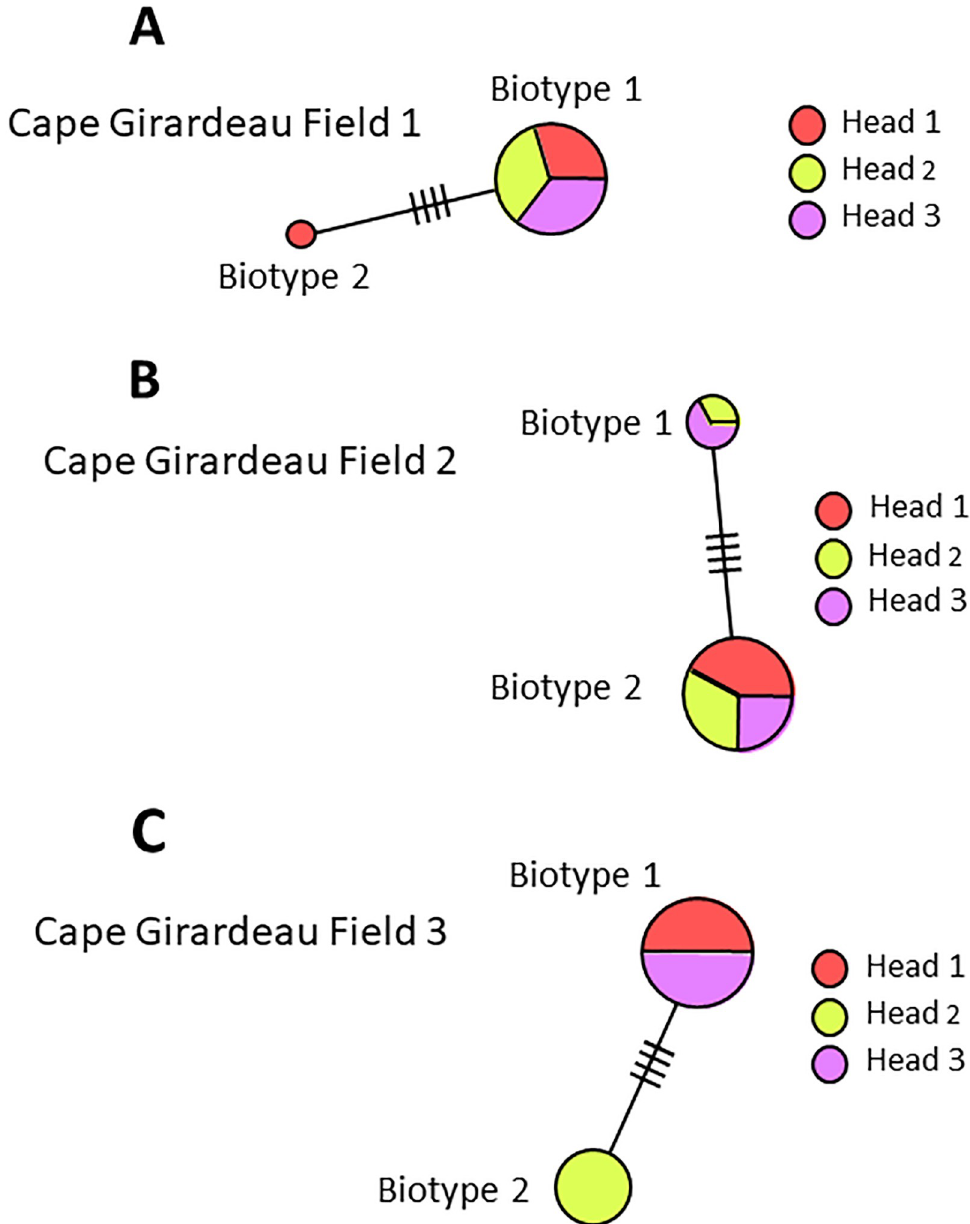
Fig 3. Phylogeny of A . tosichella haplotypes sampled in 2016. (A) Cape Girardeau county Missouri field 1 containing biotype 1 in all heads and biotype 2 in one head only; (B) Cape Girardeau county Missouri field 2 containing biotype 1 in two heads and biotype 2 in all heads; (C) Cape Girardeau county Missouri field 3 containing biotype 1 in two heads and biotype 2 in one head only. Smaller circles indicate fewer individuals in a haplotype. Hash marks on lines connecting haplotypes symbolize base-pair